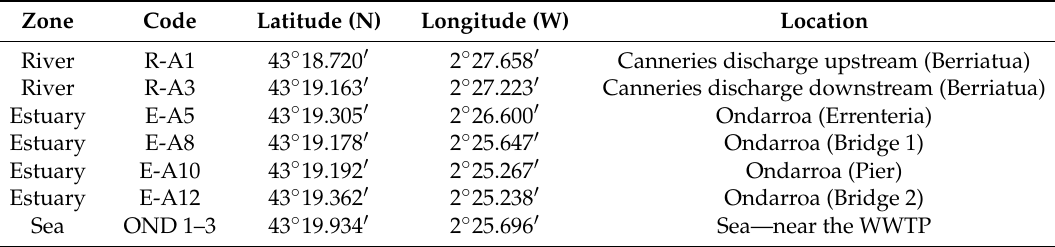
Table 2. Location of sampling